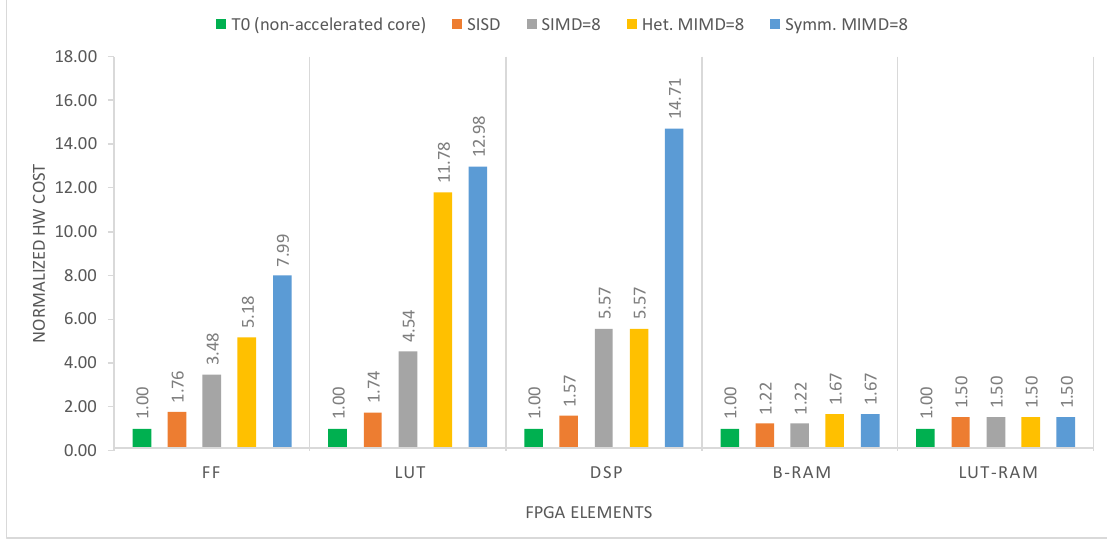
with the speed-up obtained by using the optimal configuration for each layer. the speed-up obtained by using the optimal configuration for each layer.